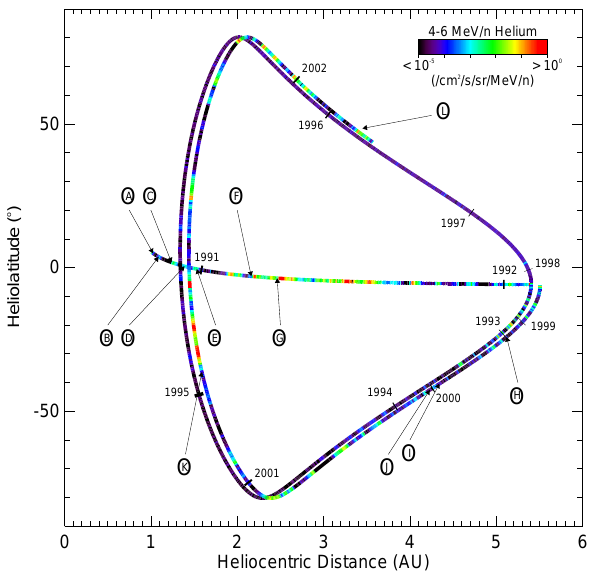
Fig. 3. The top panel shows 1.8–3.8 MeV protons and 1–5 MeV/n helium intensities (obtained from rate channels of the LET instru- ment) for a 26-day period centred about event I in 1999. The middle panel shows the solar wind speed variations as measured by the solar wind instrument (SWOOPS), and the bottom panel shows the magnetic field magnitude obtained from the magnetome- ter (VHM/FGM) on board